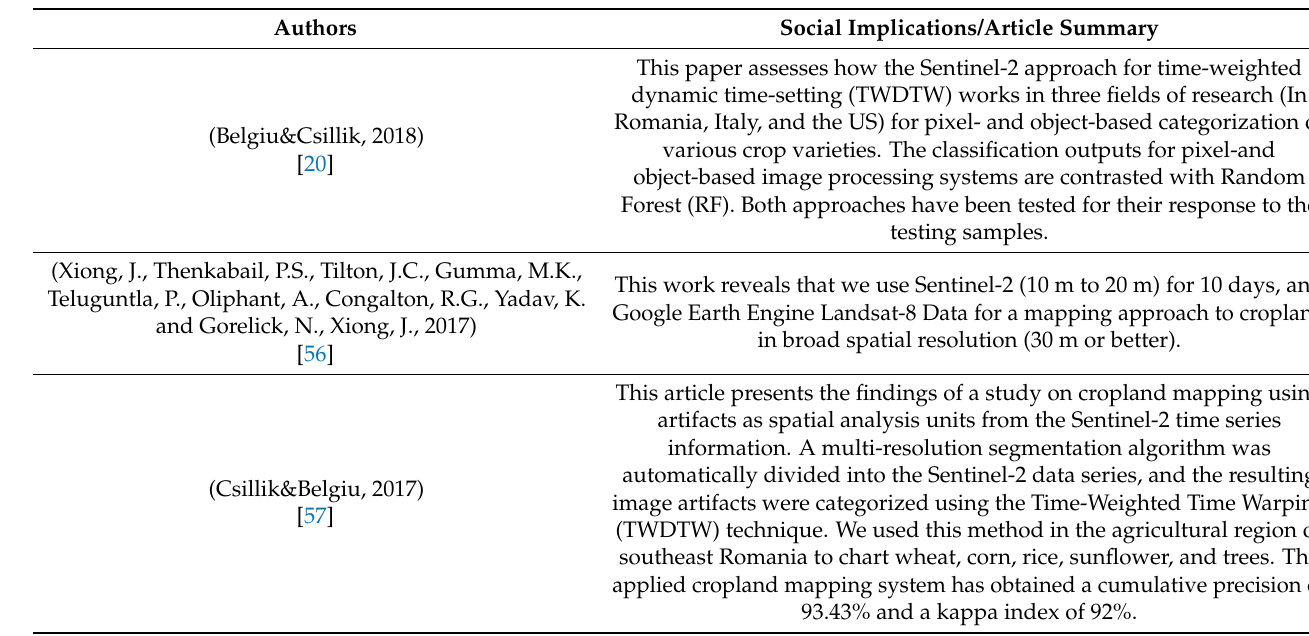
Table 1. The literature study of Sentinel-2 data analysis with Machine Learning